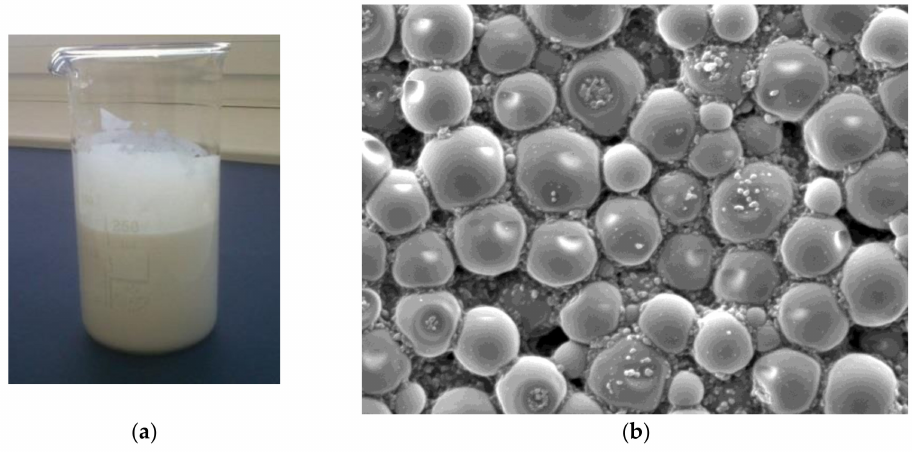
Figure 1. Microcapsules: ( a ) suspension of MC, ( b ) SEM micrograph of MC; magnification 900 ×